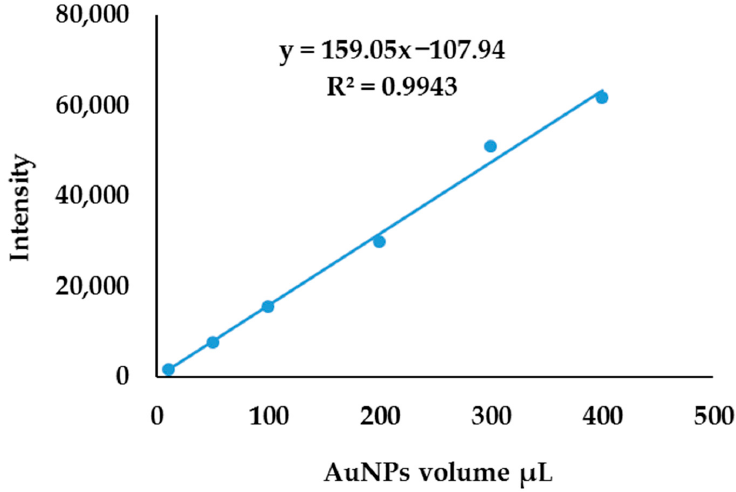
Figure 6. Calibration curve obtained by plotting intensity against AuNPs’ volume spiked .